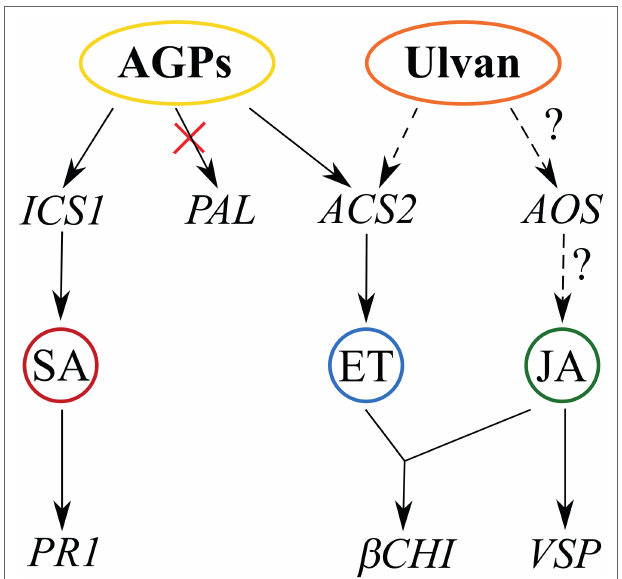
FIGURE 6 | Proposed mechanism of AGP-like enriched fraction (AGPs) and ulvan action based on transcription of signaling pathway marker genes. AGPs activate the salicylic acid signaling pathway via isochorismate synthase 1 and the ethylene signaling pathway via ACC synthase . Ulvan activates the ethylene signaling pathway based on gene expression of β CHI and probably also jasmonic acid signaling pathway based on VSP expression. Full arrows indicate proven involvement of the pathways, and dashed arrows indicate likely involvement of the